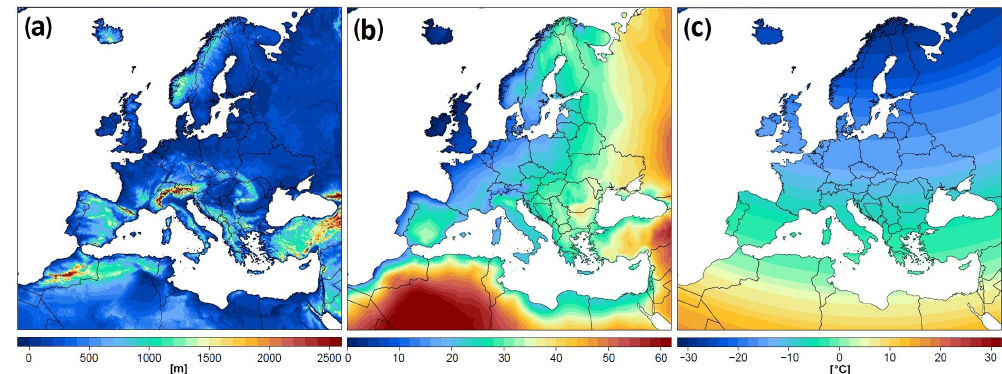
Figure 6. Predictor fields of altitude (a) , continentality (b) and zonal monthly mean temperature ( c ; here January, based on climatology